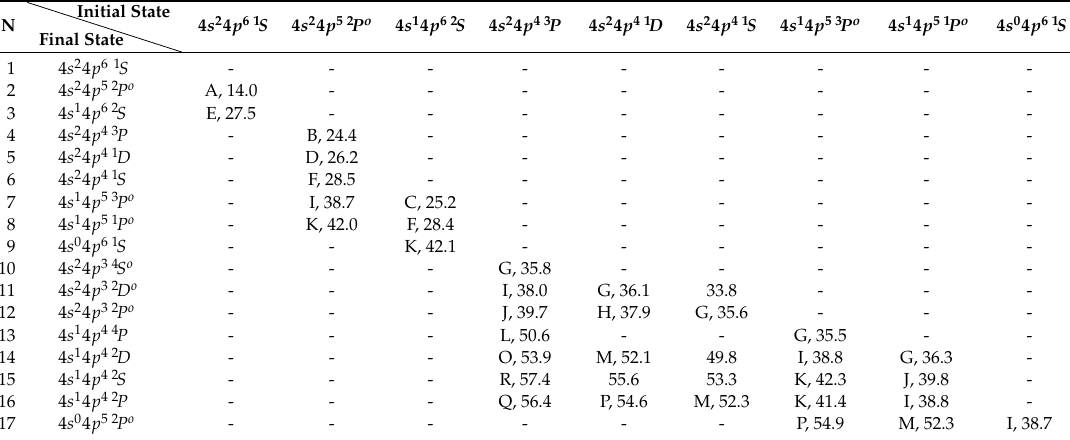
Figure 1. Scheme of transitions in sequential multiphoton ionization of Kr. Solid red arrows—photoionization, dashed blue arrows—radiative transitions. Only configurations are shown without multiplet splitting. The horizontal dash-dotted line indicates the limit for the sequential three-photon triple ionization (see text). Table 1. List of transitions in sequential three-photon ionization of Kr. Columns and lines correspond to initial and final states of the transitions within the LS-coupling scheme, respectively. Capital letters denote photoelectron lines for further convenience. Numbers after the letters present experimental ionization thresholds [21] for the corresponding transitions in eV, averaged over a multiplet. Transitions not marked by a capital letter are weak and their contribution to the photoelectron spectra is negligible, although they are included in Equations